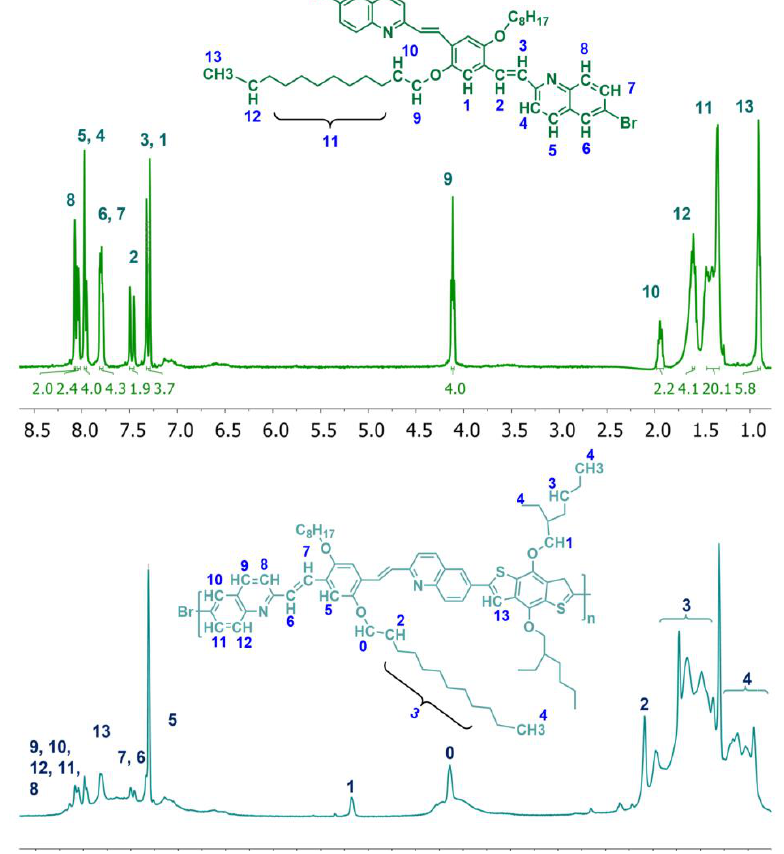
Figure 1. Comparative 1 H NMR spectra of trimer 3 and PBQT using CDCl 3 as solvent.